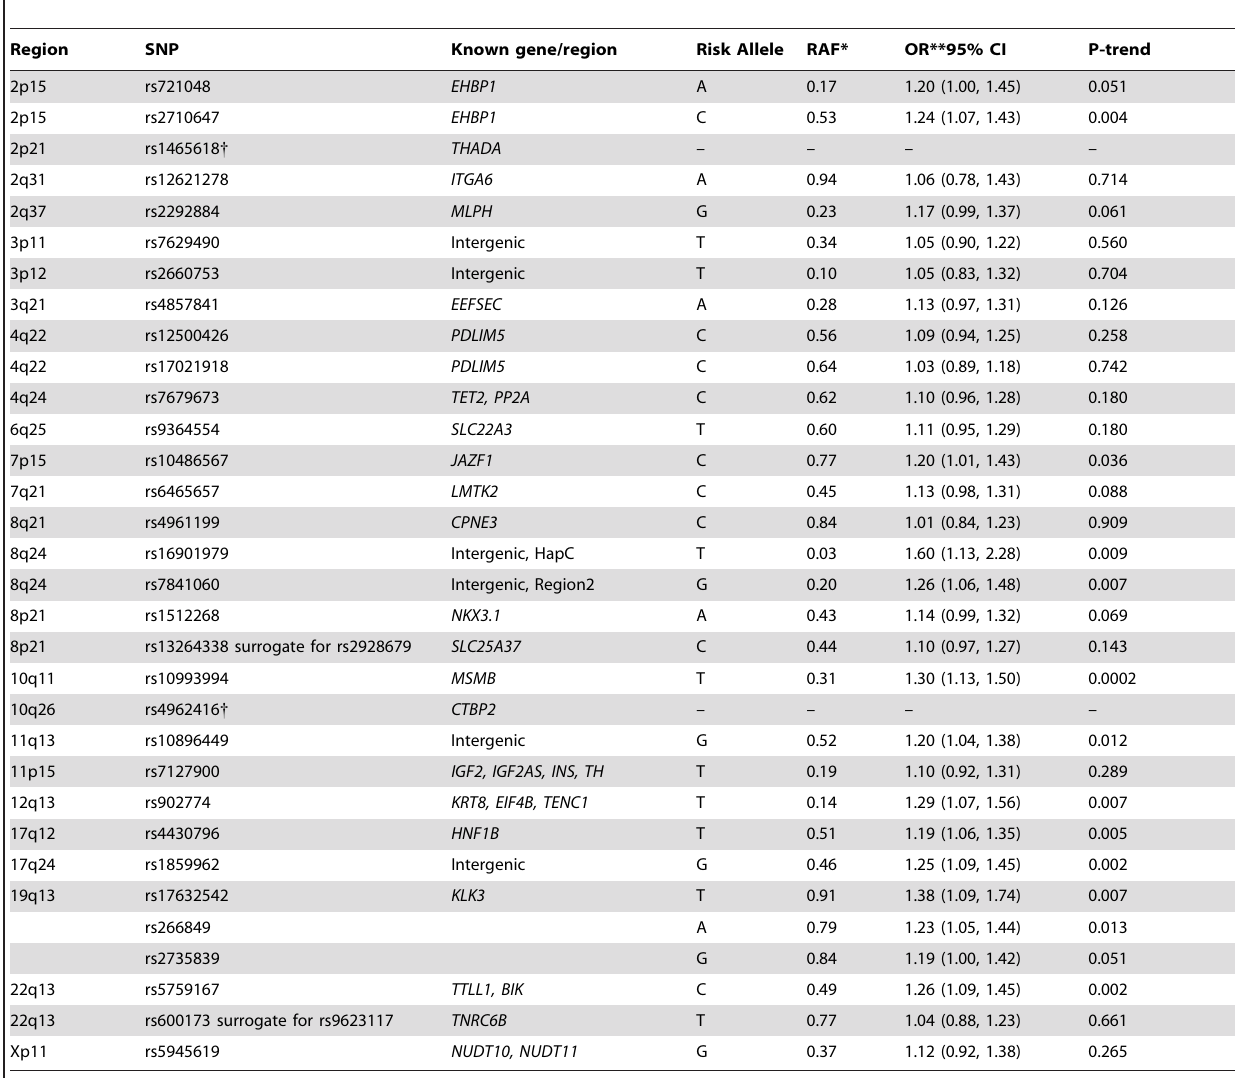
Table 2. Risk of prostate cancer in the AHS for previously reported susceptibility loci identified from genome wide association studies of prostate